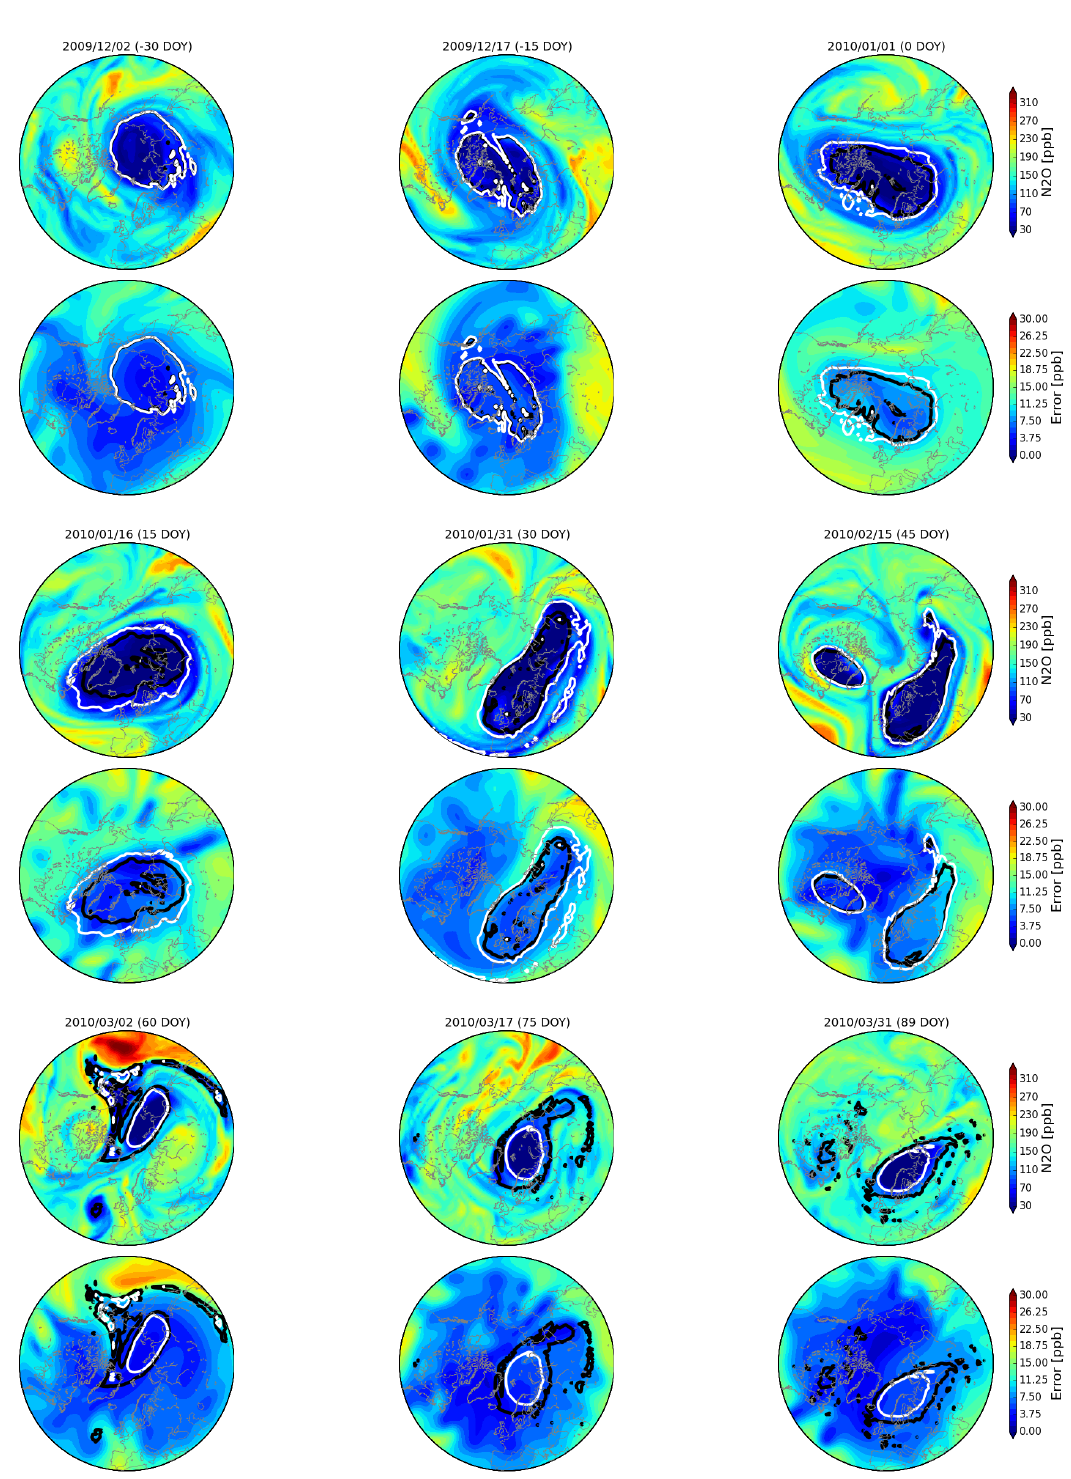
Figure 4. Modelled N 2 O fields with assimilation of SMR data (top) and their error fields (bottom) on selected dates at 600K level. The numbers in parentheses indicate the day of year. The contour lines indicate the vortex edge described by two criteria: the black line is based Fig. 4: Modeled N O fields with assimilation of SMR data (top) and their error fields (bottom) 2 on the equivalent latitude ( = 70 ◦ N) and the white line is based on Lait’s potential vorticity (=38PVU=3.8 × 10 − 6 Km 2 kg − 1 s − 1 on selected dates at 600K level. The number in the bracket indicates the days of year. The con- tour lines indicate the vortex edge described with two criteria. The black line is based on the equivalent latitude ( = 70 N) and the white line is based on Lait’s potential vorticity ( = 38PVU = ◦ 3 . 8 10 − 6 Km 2 kg − 1 s − 1 ). ×